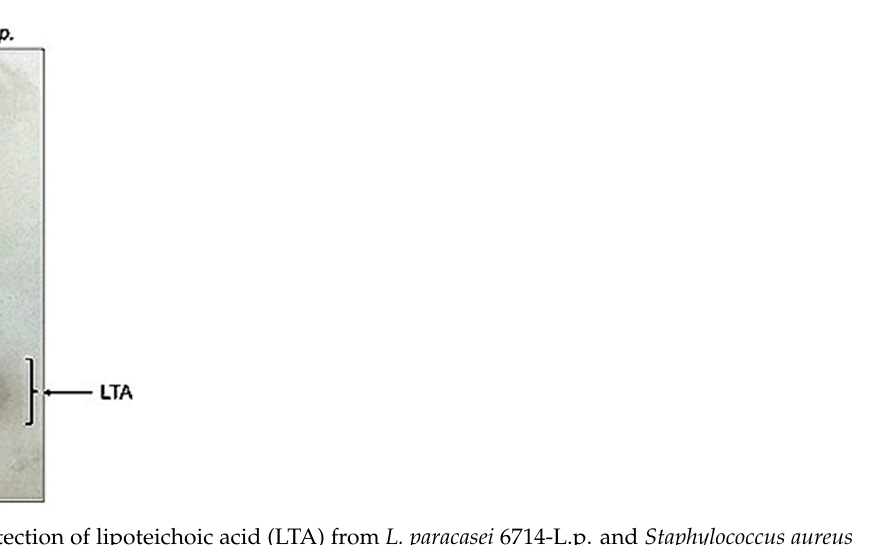
Figure 4. Detection of lipoteichoic acid (LTA) from L. paracasei 6714-L.p. and Staphylococcus aureus (S.a.) (positive control: Sigma Aldrich—PN L2515). LTA was loaded in 20% PAGE gel and visualized using the Alcian blue–silver staining method. The bracket indicates the LTA band of L. paracasei 6714 .